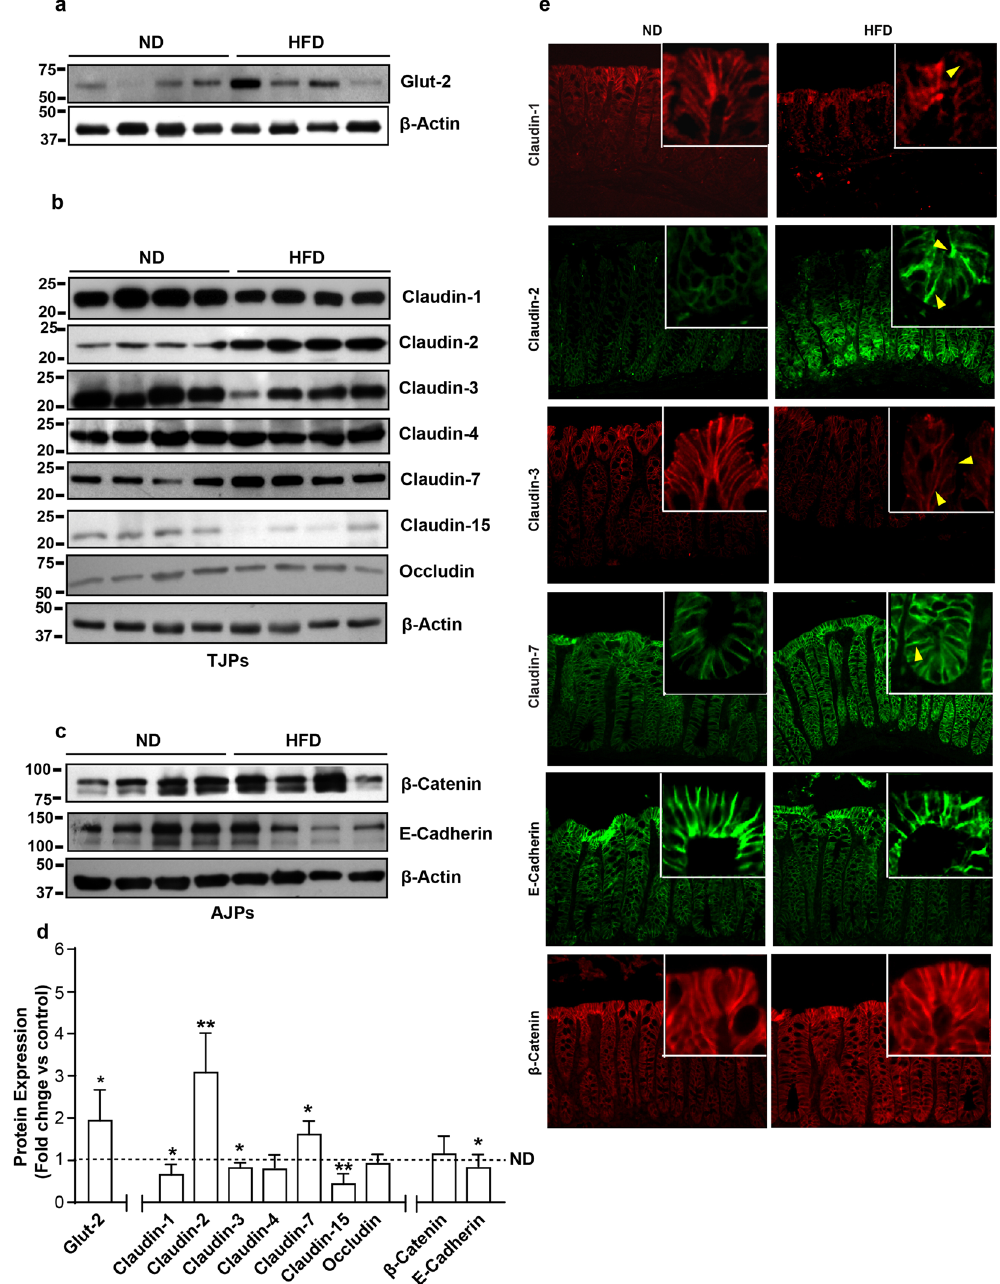
Figure 3. High fat diet induces colon specific restructuring of tight junction and adherent junction: Immunoblot analysis of total tissue lysate prepared using the Colon from ND- and HFD-fed mice (N = 4). ( a ) Glut-2 expression in HFD and ND-fed mice, as positive control; ( b ) Immunoblot analysis to determine changes in TJPs using antigen-specific antibodies; ( c ) Immunoblot analysis to determine changes in AJPs including E-cadherin and β -catenin; ( d ) Densitometry analysis of the immunoblot band intensity for respective protein; ( e ) Representative immunofluorescent images of TJ and AJPs of colon from HFD- and ND-fed mice. Values are presented as mean ± SEM ** P ≤ 0.01; * P ≤ 0.05 compared to control (normal chow fed mice; ND)